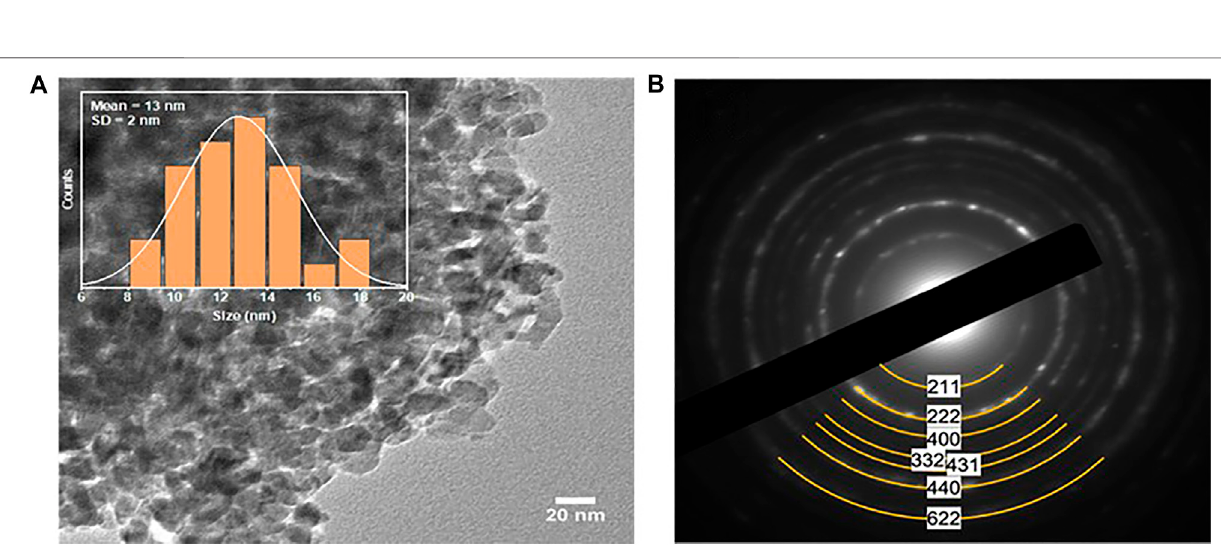
Frontiers in Chemistry |